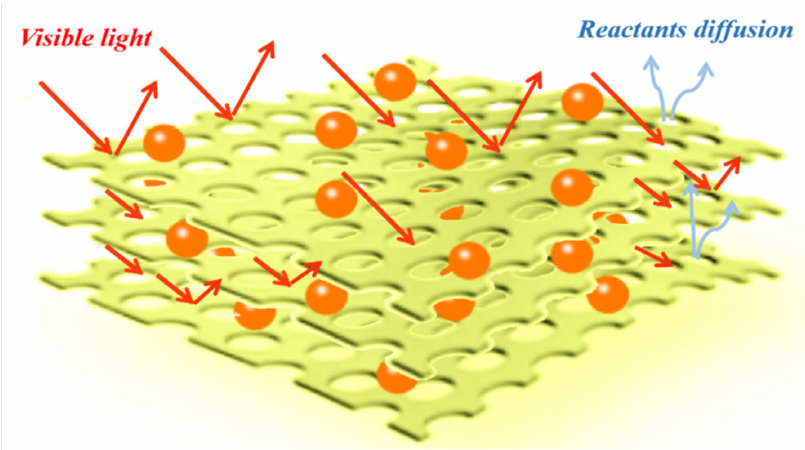
Figure 7. Schematics of honeycomb-like